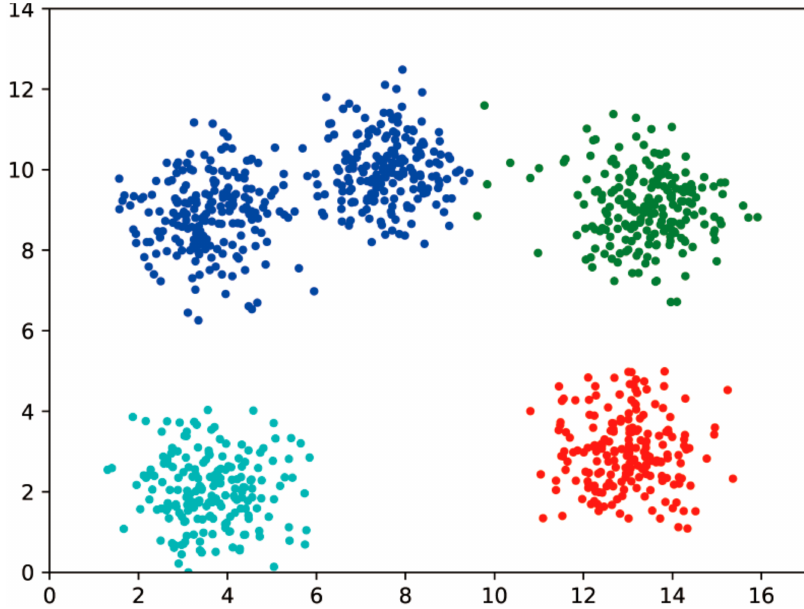
Figure 11. Dataset A retains 5 decimal ciphertext clustering results.